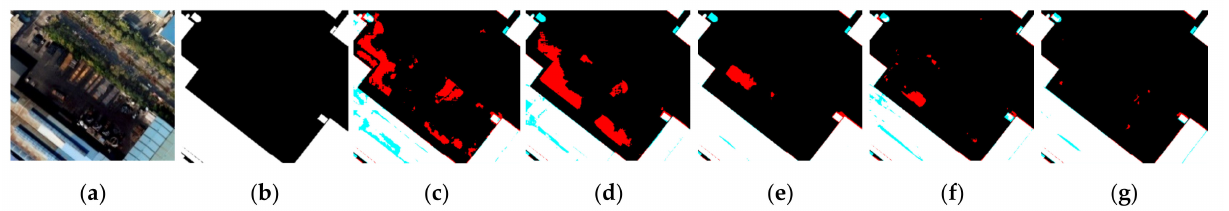
Figure 11. Detailed results for site 1 (industrial area) according to each deep learning model. Red indicates false positives, and cyan indicates false negatives. ( a ) Original image. ( b ) Ground-truth labels. ( c ) Results of SegNet. ( d ) Results of U-Net. ( e ) Results of FC-DenseNet. ( f ) Results of HRNet-v2. ( g ) Results of